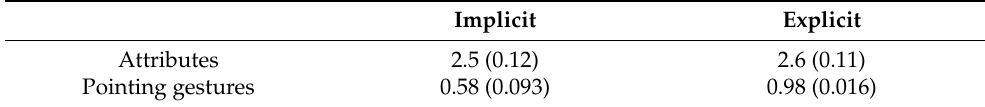
Table 3. Comparison of mean number of object attributes and pointing gestures included in references with standard error between explicit request and implicit entrainment